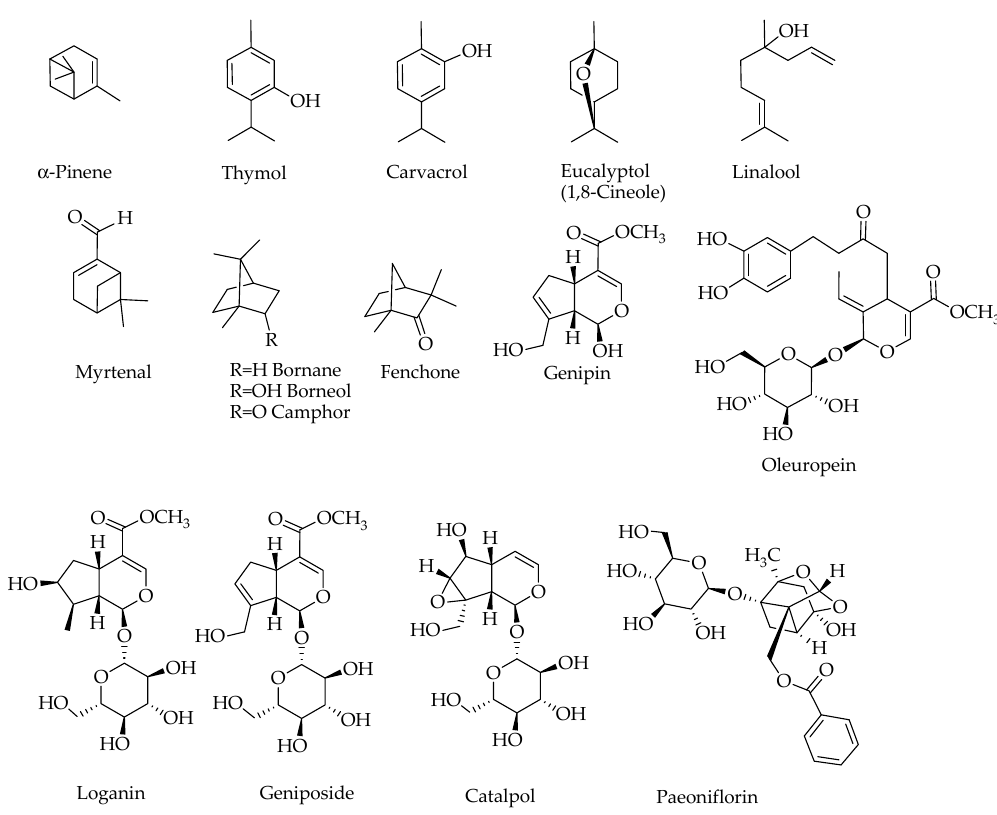
Figure 3. Structures of compounds with potential effects on the Alzheimer’s brain. Note that compounds containing a sugar moiety (oleuropein, loganin, geniposide, catalpol and paeoniflorin) are highly polar and hence are not components of essential oils.